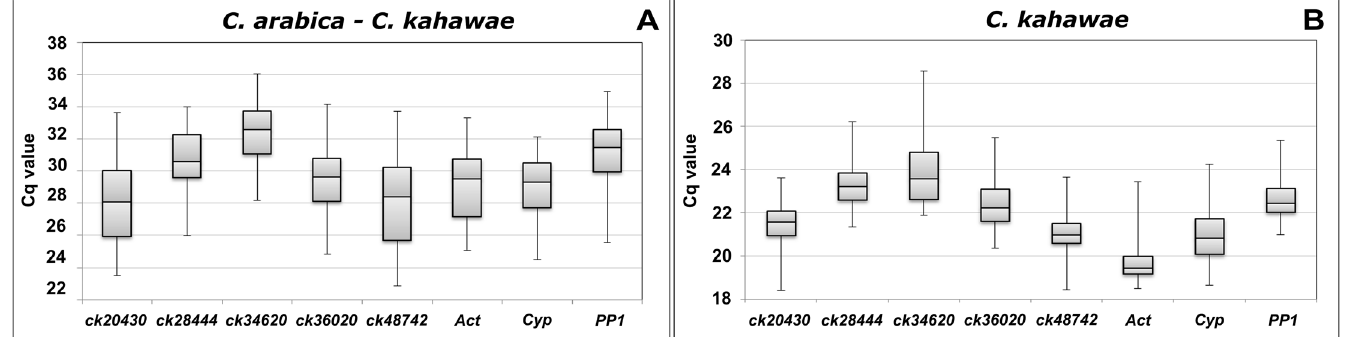
Fig 1. Box and whisker plots of Cq values for each reference gene across the experimental samples. A) C . arabica-C . kahawae samples; B) C . kahawae samples. The boxes indicate the 25th and 75th percentiles. Lines within the boxes represent the median Cq values; the whiskers mark minimum and maximum values in each data